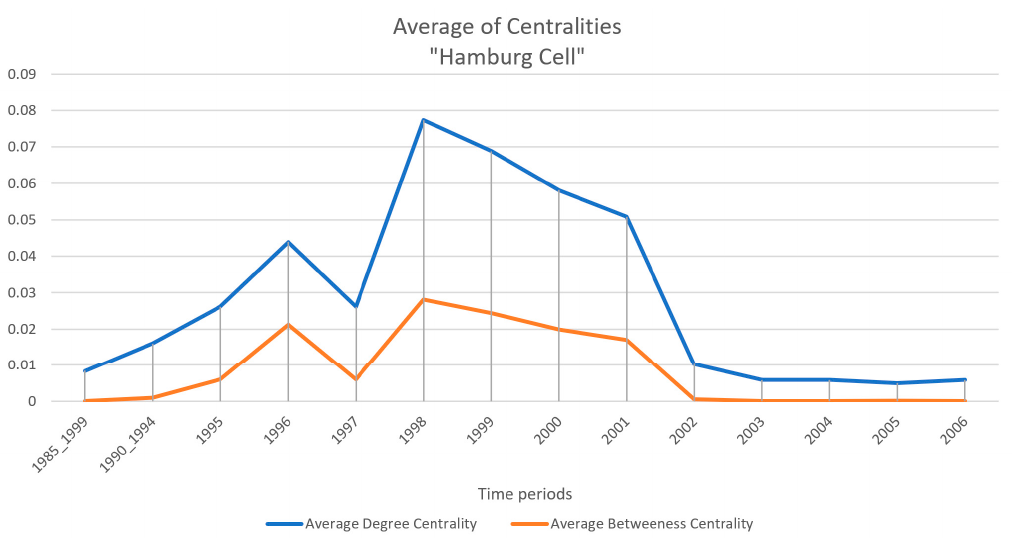
Figure 14. Temporal development of average degree centrality and average betweenness centrality for the “Hamburg Cell”. Both indices fluctuate, with two maximum values in 1996 and 1998. Both indices decrease rapidly after 2001.